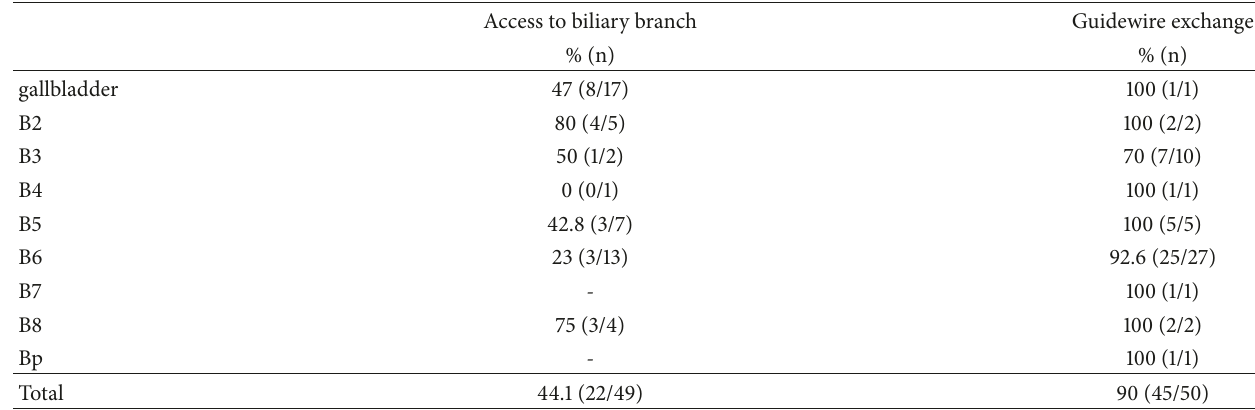
Table 4: The success rate according to the targeted biliary